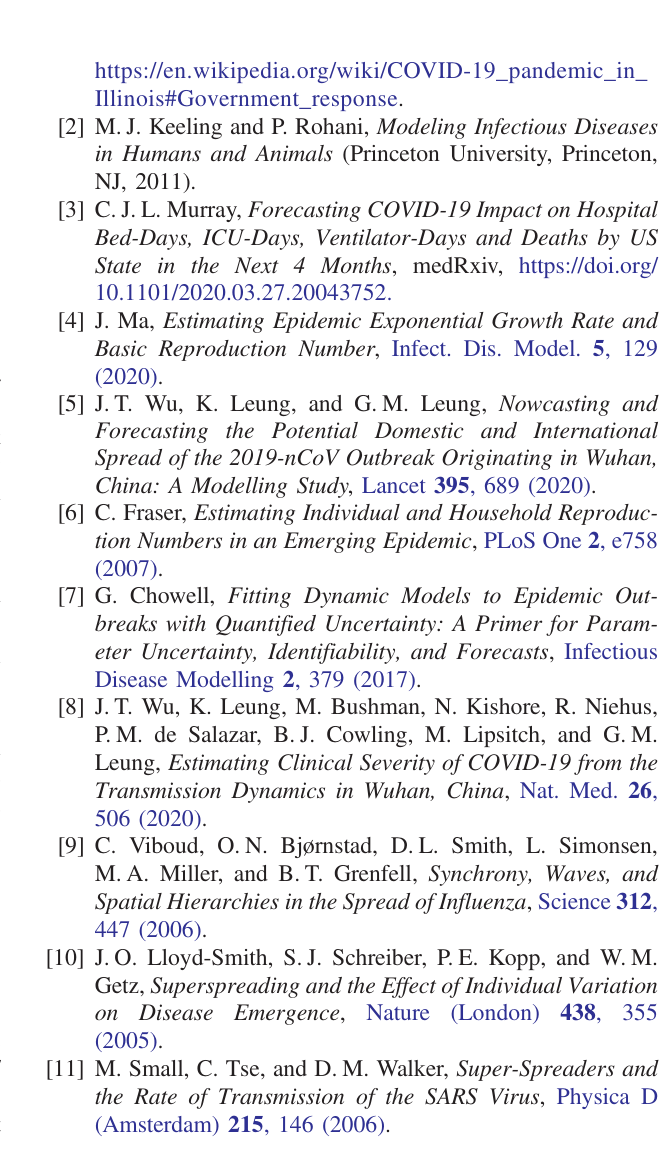
14. Quantification of the dispersion of reported data in Illinois. For both the daily incidence of hospital deaths and of reported positive tests (right panel), we plot histograms of the raw data normalized by its 7-day rolling average. To compare this measure to theoretical distributions, we additionally plot the same measure of random samples of the Poisson distribution and negative binomial distribution (with dispersion coefficient k ¼ 0 . 1 ), averaging over 1000 such samples. Note that we do not consider positive tests in our calibration